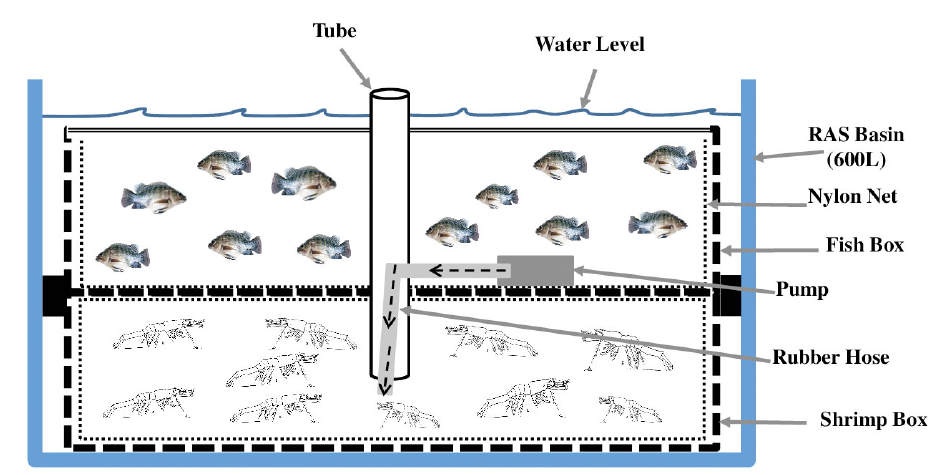
Fig. 1. Cross-sectional view of a whiteleg shrimp Lito - penaeus vannamei and Nile tilapia Oreochromis niloticus co-culture unit showing the different ex- perimental system compo- nents. RAS: recirculating aquaculture